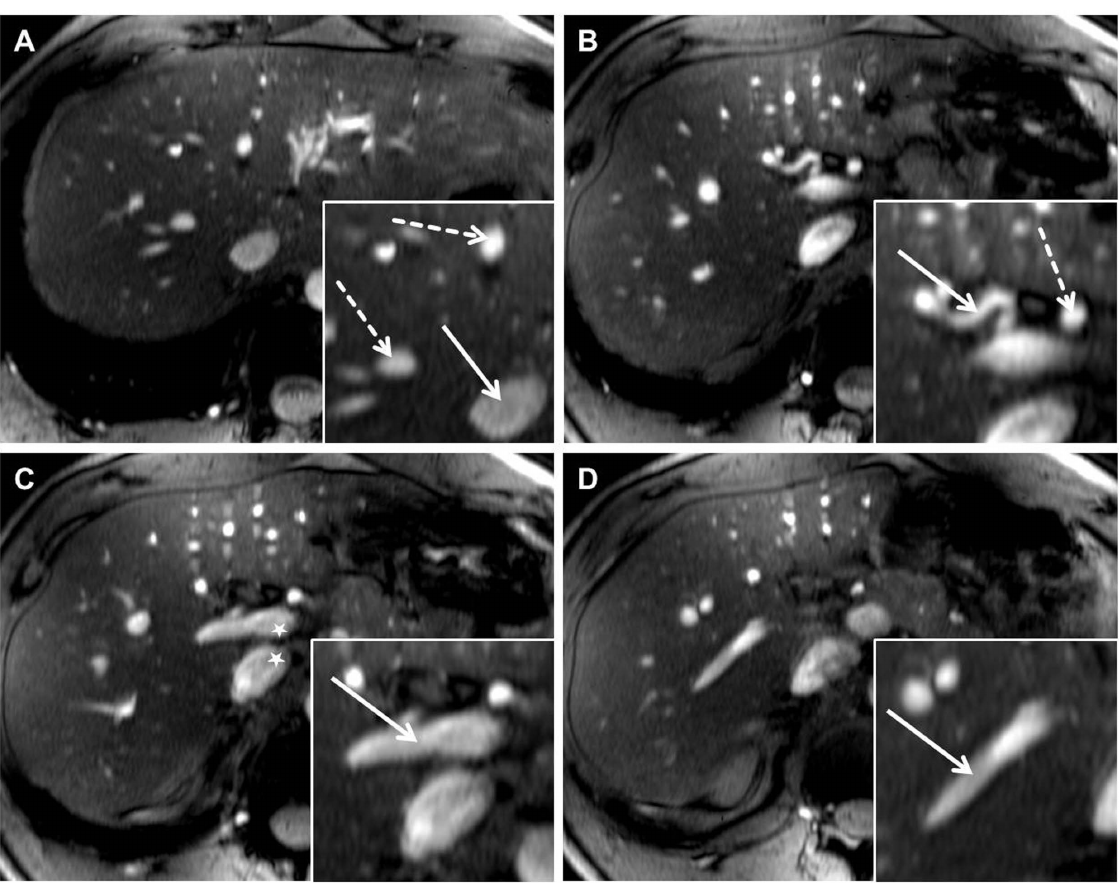
Figure 4. TOF MRA demonstrated high quality delineation of all analyzed liver vessel segments due to a hyperintensive vessel signal and an effective suppression of background signal. Figure A shows the inferior vena cava (arrow) as well as the right and middle hepatic veins (dashed arrow). A major part of the right hepatic artery (arrow) and a section of the common hepatic artery (dashed arrow) are visualized in Figure B. Figure C and D show the hyperintense delineation of the main portal vein (arrow) and the right portal vein (arrow). A slight intraluminal signal inhomogeneity could be depicted in the main portal vein and inferior vena cava (Figure C, star). Furthermore, signal drop outs due to susceptibility are visible in the stomach in the left ventral abdomen, but do not hamper vessel visualization (Figure